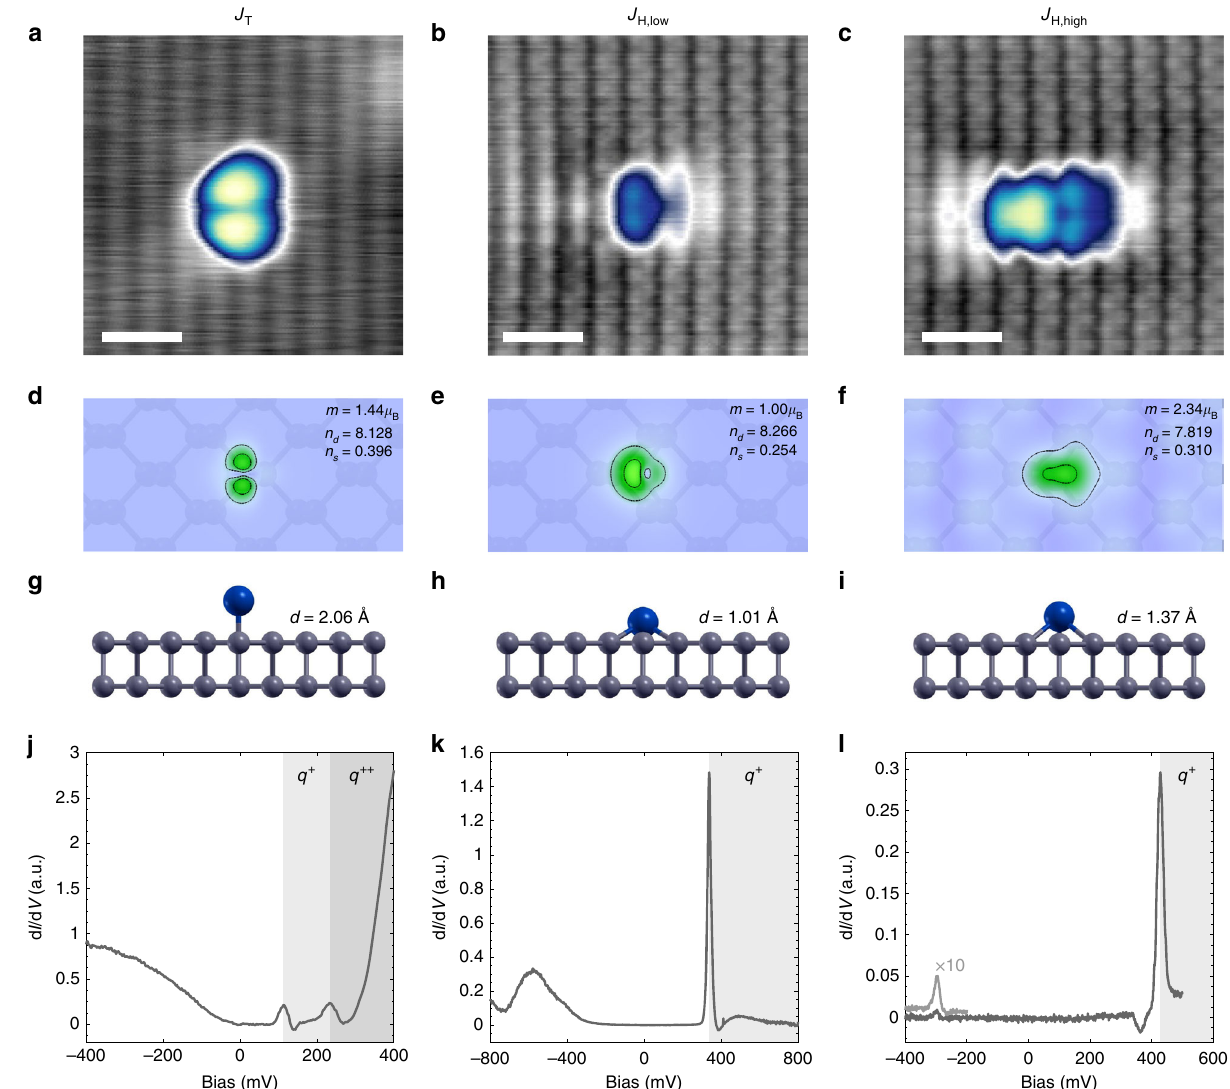
Fig. 2 Ground states of Co atoms. High-resolution image of Co in a J T ( V s = − 400 mV, I t = 200 pA, scale bar = 1 nm), b J H,low ( V s = − 60 mV, I t = 200 pA, scale bar = 1 nm), and c J H,high ( V s = − 60 mV, I t = 200 pA, scale bar = 1 nm) con fi gurations with same color scale as Fig. 1. DFT calculations of charge density distributions, including magnetic moment ( m ), n d , and n s , for d Co on a top site, e Co in a hollow site, and f Co in a hollow site with U = 4